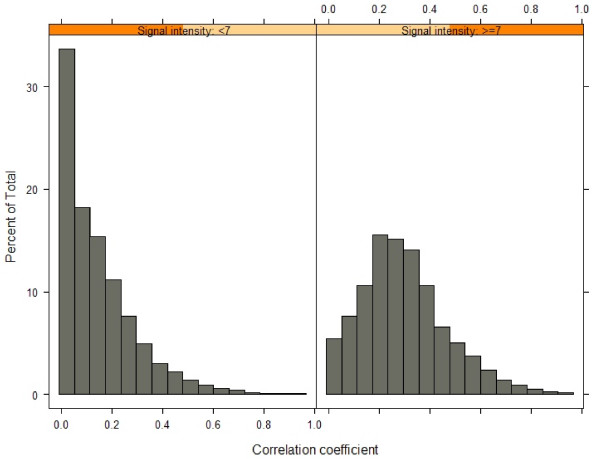
Distribution of correlation coefficients among probe sets (Microarray study). Probe sets satisfying the Shapiro test were divided in two sets according to their average signal intensities: below or above log2 7. Distributions of the probe sets according to correlation coefficient values are displayed for both sets.